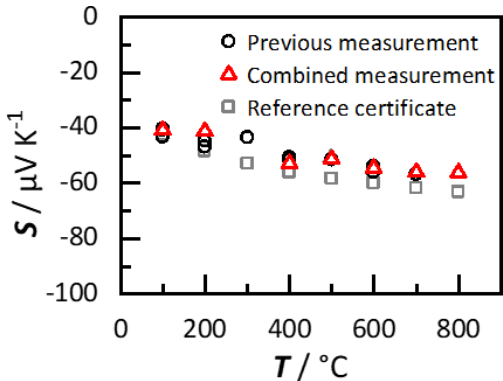
Figure 13. Seebeck coefficient of constantan up to 800 ◦ C. Addi- tionally, all previous measurements and the values of the reference certificate are